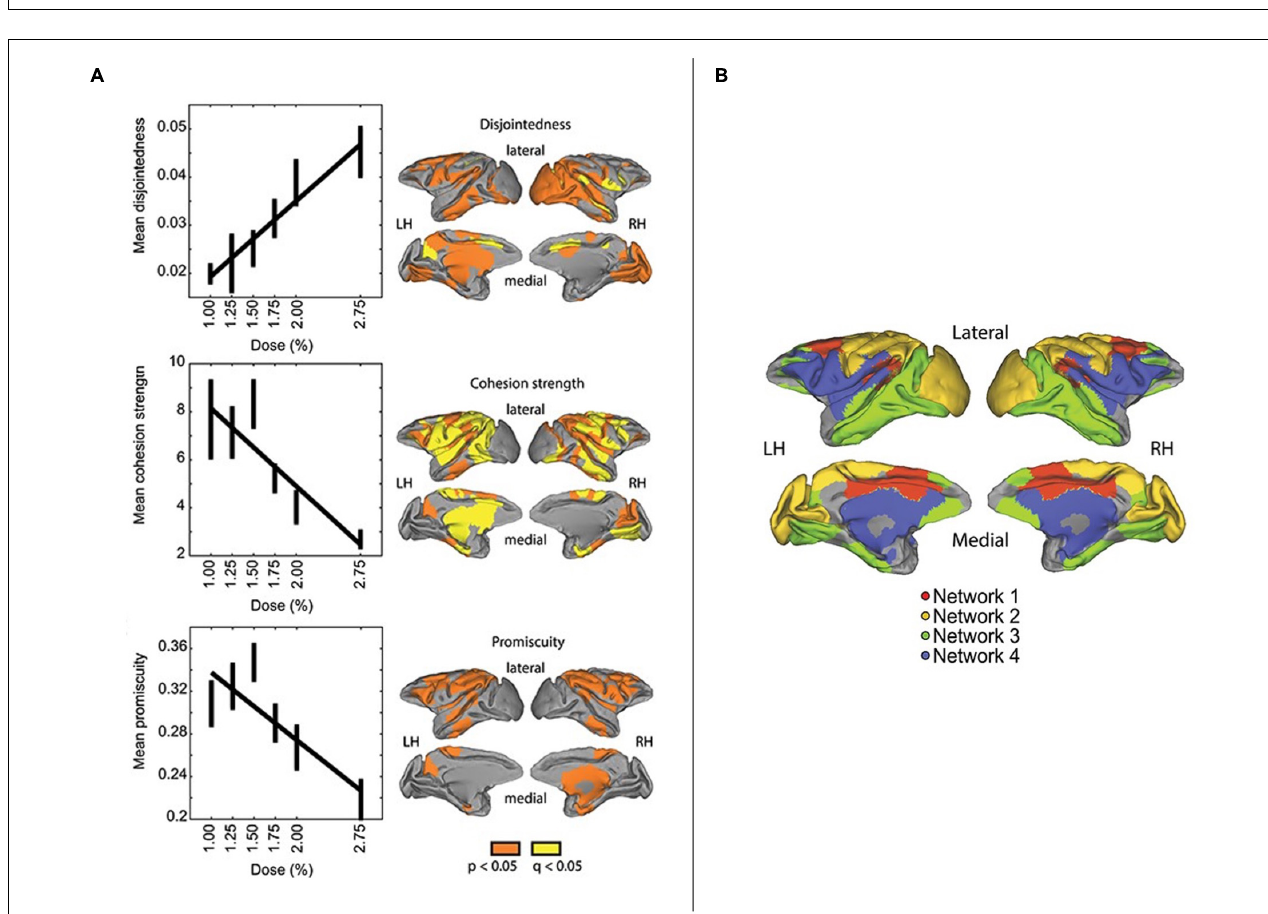
FIGURE 6 | Reprinted with permissions from Standage et al. (2020). On the (Left) : relationship between isoflurane dose and mean disjointedness (top panel), mean cohesion strength (middle panel), and mean promiscuity (bottom panel) across the whole brain. The brain images directly next to these graphs show regions where the relationship between the dose and measure was significant (in orange), and significant with an additional false discovery rate correction (in yellow). On the (Right) : network architecture identified in the study, depicting four networks: 1/red = cingulate-temporal-parietal; 2/yellow = visual-somatomotor; 3/green = temporal-parietal-prefrontal; 4/blue = lateral parietal-frontal cingulate